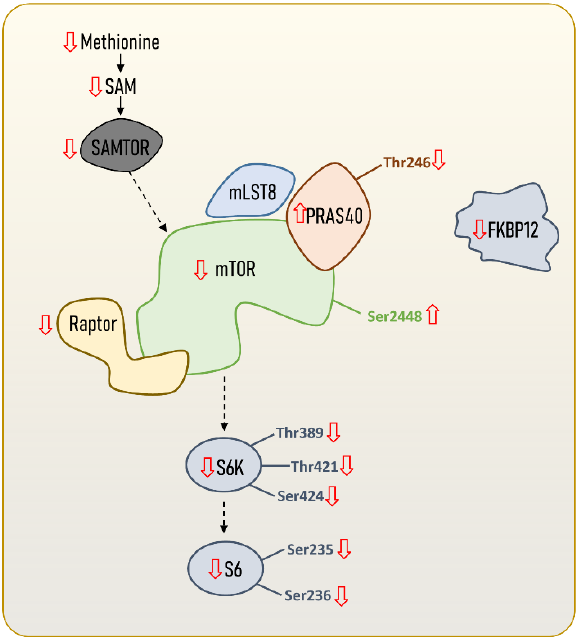
Figure 2. mTORC1 content and regulation in long-lived animal species, including humans. Steady- state levels of mTORC1 core elements and regulators are downregulated in long-lived species compared to short-lived ones. The content and regulation of other mTORC1 downstream proteins and transcript factors different from S6K and S6 are not included, since no data are available. However, scientific evidence suggests that there might also be specific regulations in downstream proteins or transcriptional factors targeting autophagy (e.g., ATG13, ULK1), mitochondrial biogenesis (e.g., PGC1 α ), lipids (e.g., SRBEP1, Lipin1, PP2A) and protein metabolism (e.g., 4E-BP1). Increased or reduced content of mTORC1 core elements and regulators can refer to either transcript content, gene expression, protein content, or metabolite content.